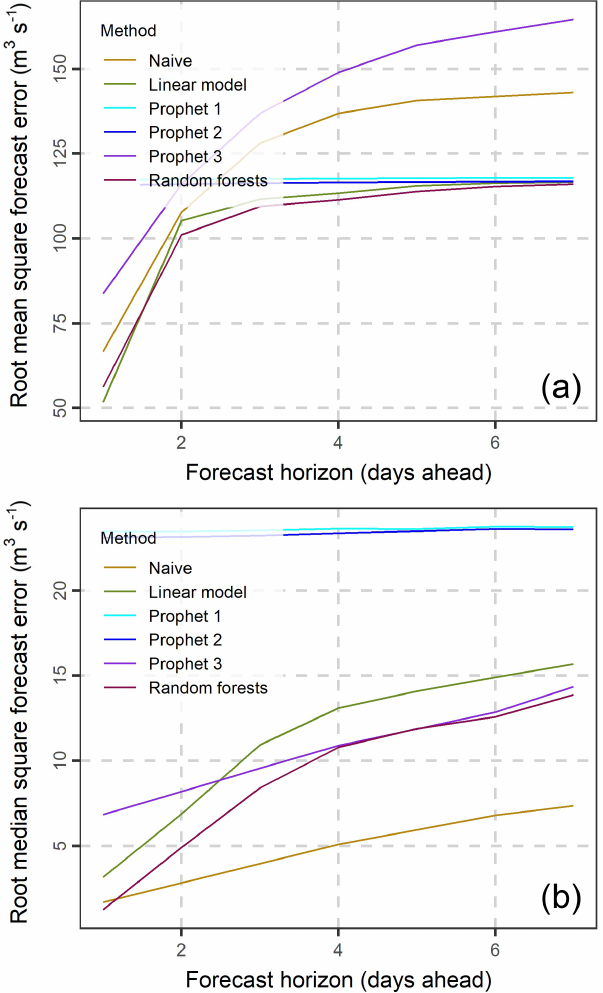
Figure 4. Root mean square forecast errors (a) and root median square forecast errors (b)